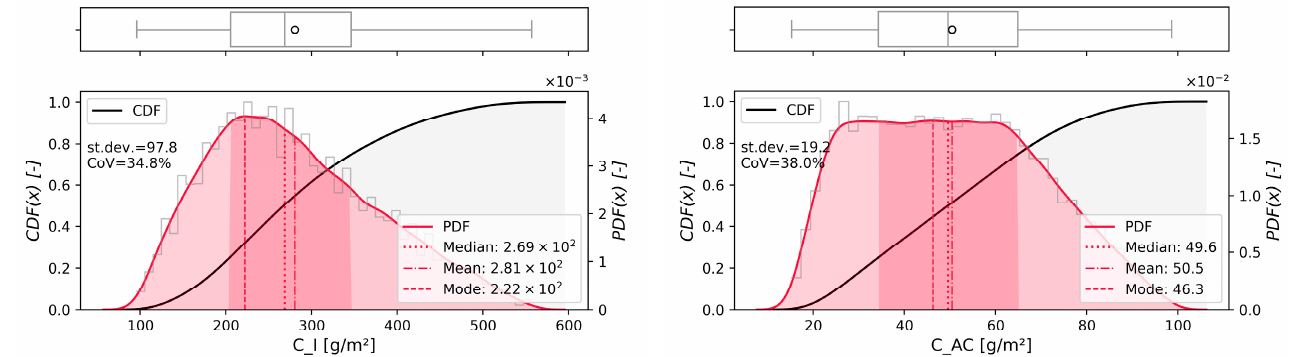
Figure 2. PDFs, CDFs, and box-whisker plots for C I and C AC .